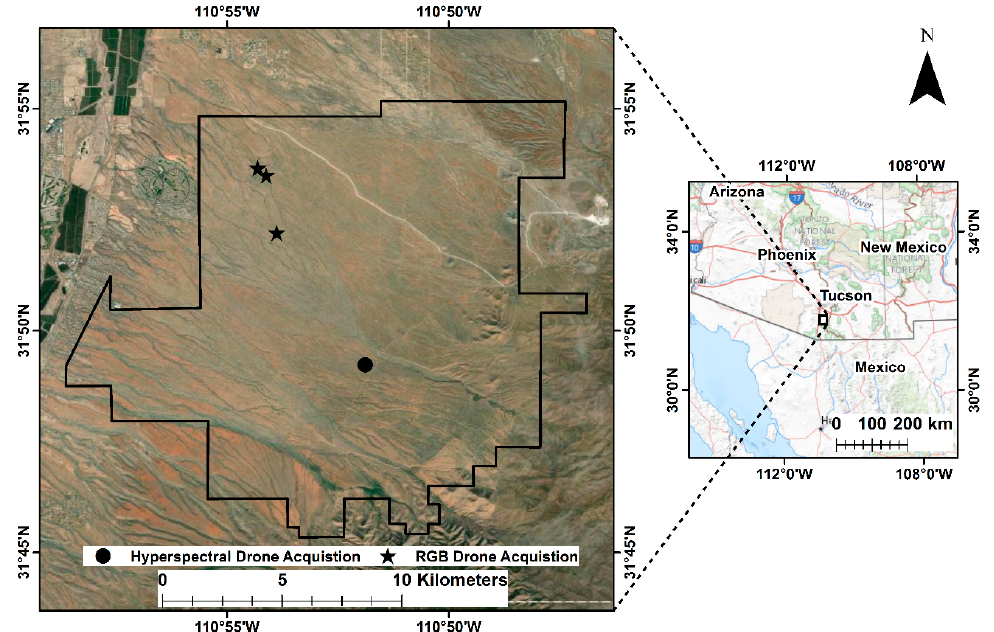
Figure 1. We conducted this study at the Santa Rita Experimental Range (SRER), located about 30 km south of Tucson, Arizona. We identified cacti samples for the NEON AVIRIS imagery analysis using photos acquired with a DJI Mavic Pro multirotor in the northwest portion of the study area (black stars), an area with a high density of cacti. We collected drone-mounted hyperspectral imagery in the center of the SRER, where prickly pear and barrel cacti are plentiful (black circle). SRER is located in a semi ‐ arid ecosystem with a bimodal precipitation distribution.